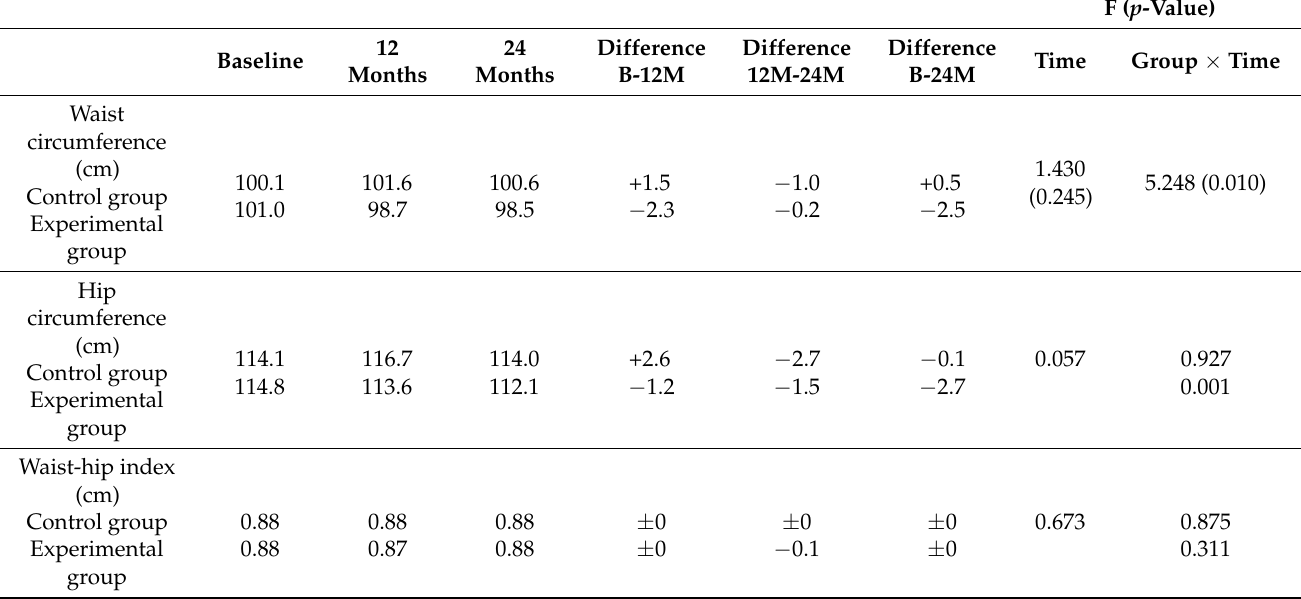
Table 4. Changes in waist circumference, hip circumference, and waist–hip index.